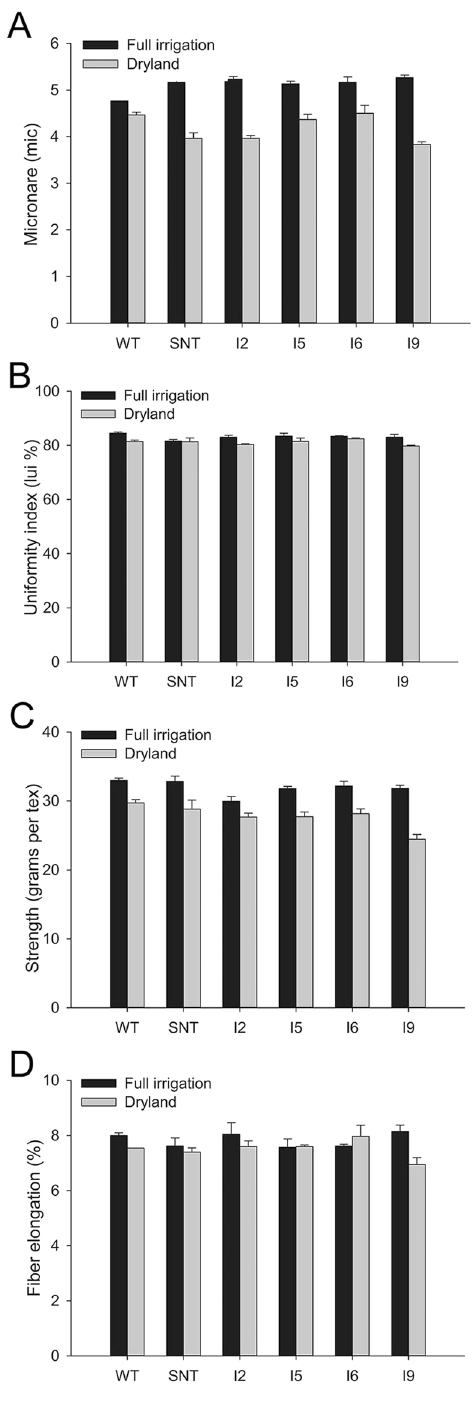
Figure 3. Fiber quality analyses for cotton lines grown under full irrigation and dryland conditions in 2011. WT, wild-type cotton (Coker 312); SNT, segregated non-transgenic cotton; IPT2 to IPT9, four independent IPT -transgenic cotton